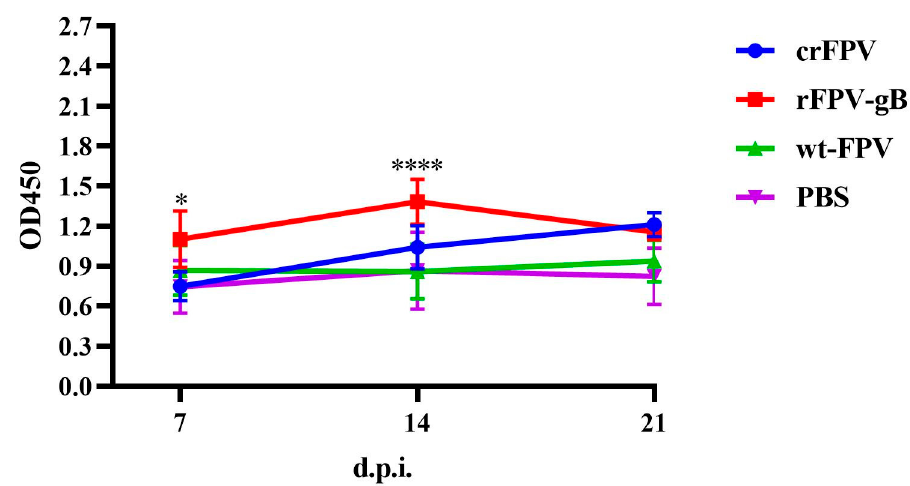
Figure 7. Antibody responses to ILTV after vaccination. The antibody titers to gB induced by rFPV-gB or crFPV were detected by enzyme-linked immunosorbent assay. The 96-well plates were coated with purified recombinant gB protein (0.125 µg/well) and blocked with 3% skim milk, then washed using phosphate buffered saline with tween 20 (PBST). The serum samples from immunized chickens were collected at 7, 14, and 21 days after vaccination and serially diluted 2-fold in blocking buffer in a range of 10 − 1 –10 − 8 , added to the wells (100 µL). The plates were then washed. Horseradish peroxidase (HRP)-labeled goat anti-chicken immunoglobulin G (IgG) was diluted (1:5000) with PBST buffer and added into plates for incubation. After washing five times, soluble tetramethyl benzidine (TMB) solution was added (100 µL), and plates were incubated in the dark at room temperature for 30 min. The reaction was terminated with 2M H 2 SO 4 and absorbance of each well was read at a wavelength of 450 nm by a microplate absorbance reader. The antibody titers of rFPV-gB or crFPV were analyzed by graphpad 2-way analysis of variance (ANOVA), * = p < 0.05, **** = p < 0.0001.